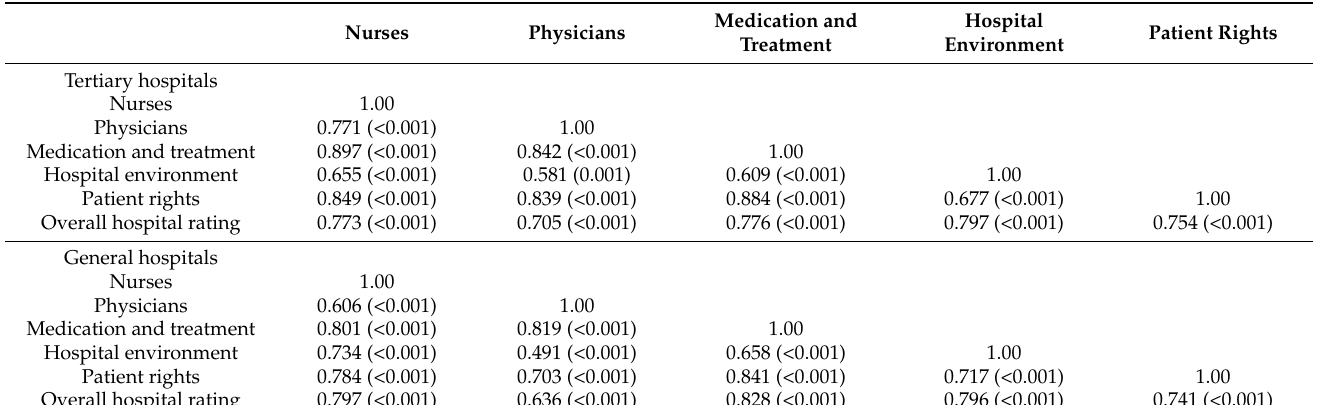
Table 2. Pearson correlation coefficients ( p -values) among the patient experience dimensions (n = 146).